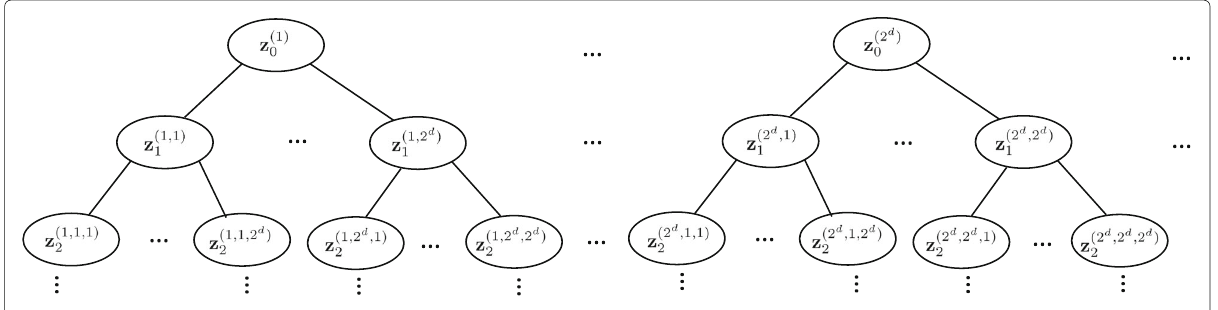
Fig. 1 Full hypothesis tree for a system with d Boolean